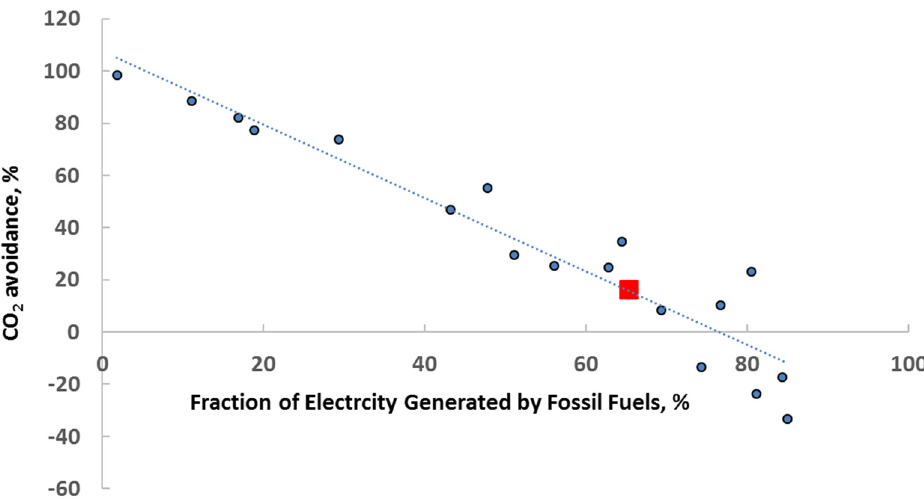
Figure 5. Graphical representation of the CO 2 avoidance results.